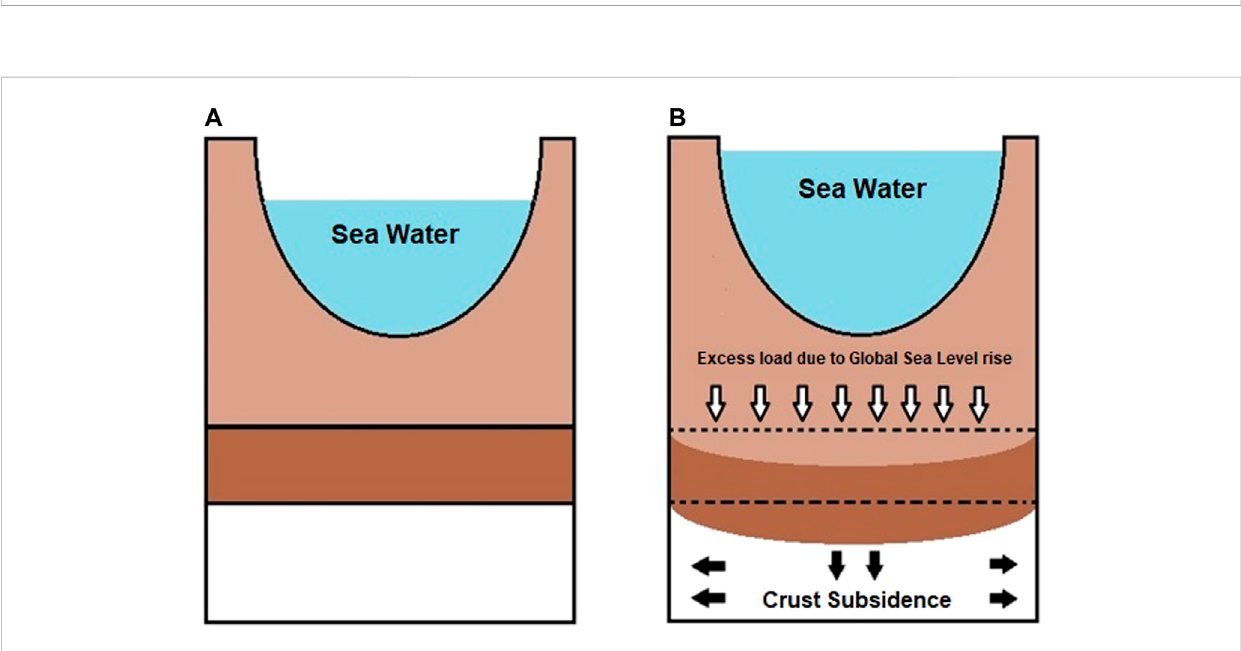
FIGURE 5 Land subsidence caused by additional